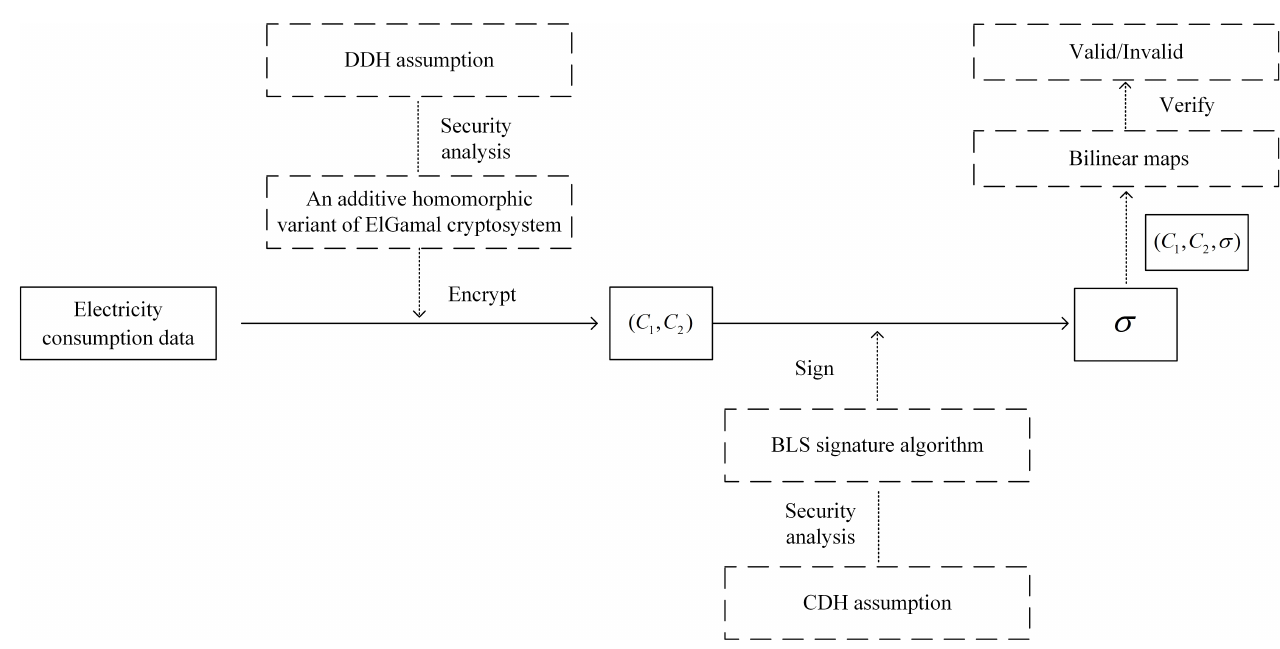
Figure 1. Relationship between Sections